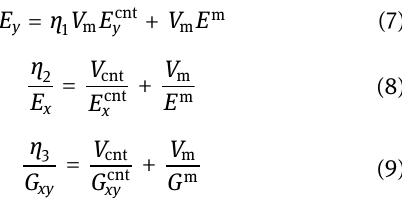
Figure 2: Cross section of UD, FG - Λ , FG - V, FG - O, and FG - X CNTRC [ 38 ]